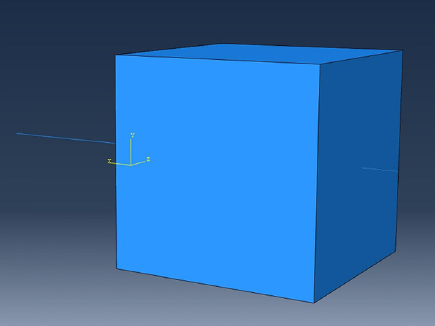
Figure 5: Finite element model.